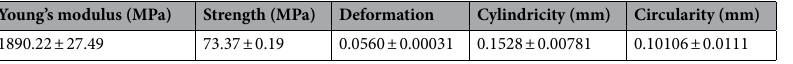
Table 11. Measured values of